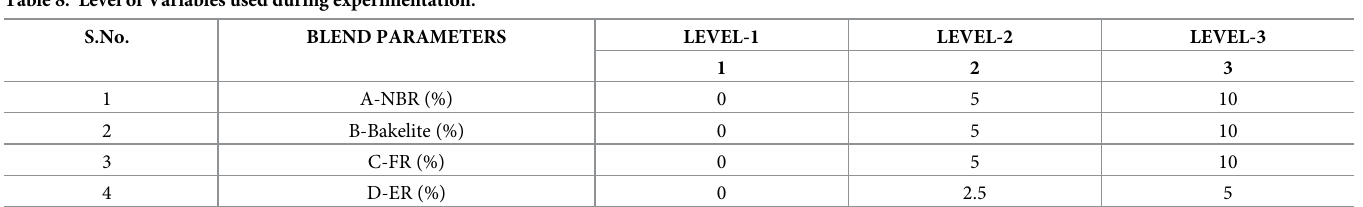
Table 8. Level of Variables used during experimentation.